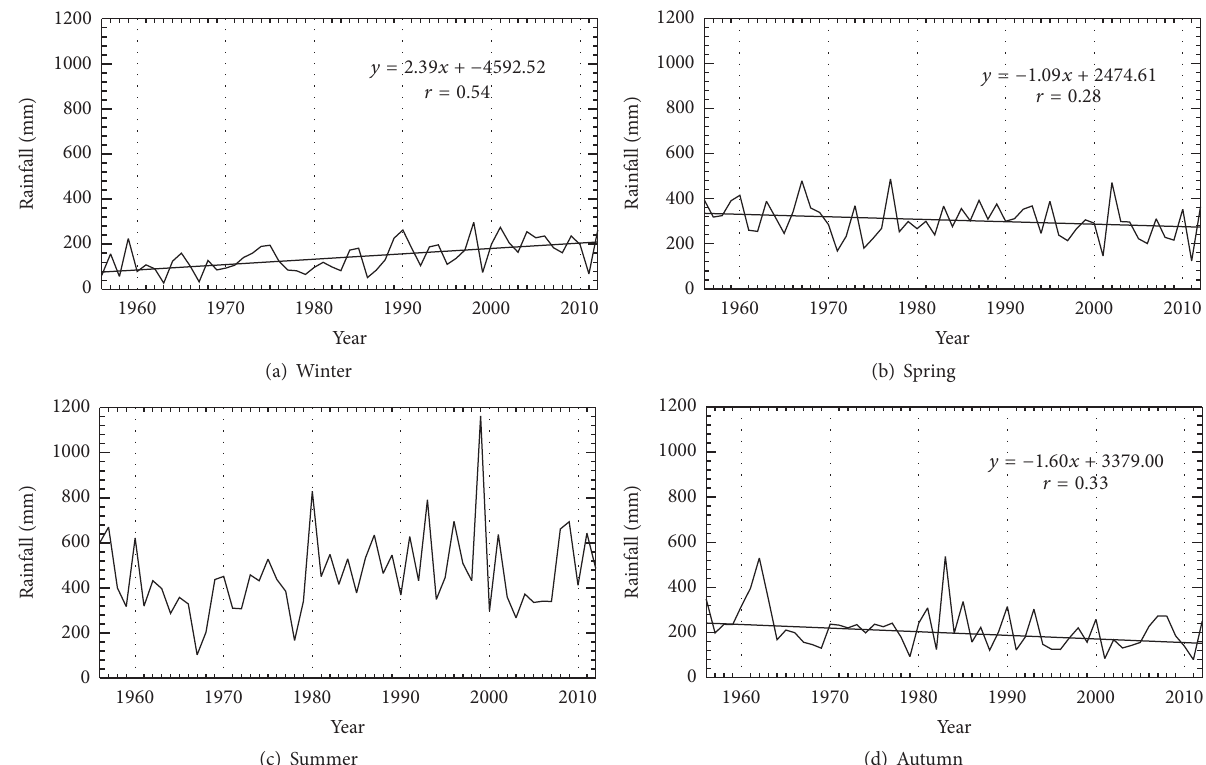
Figure 3: Time series of seasonal rainfall during the period 1956–2012. Linear trend lines are plotted for series with trends significant at 95% confidence level or greater.